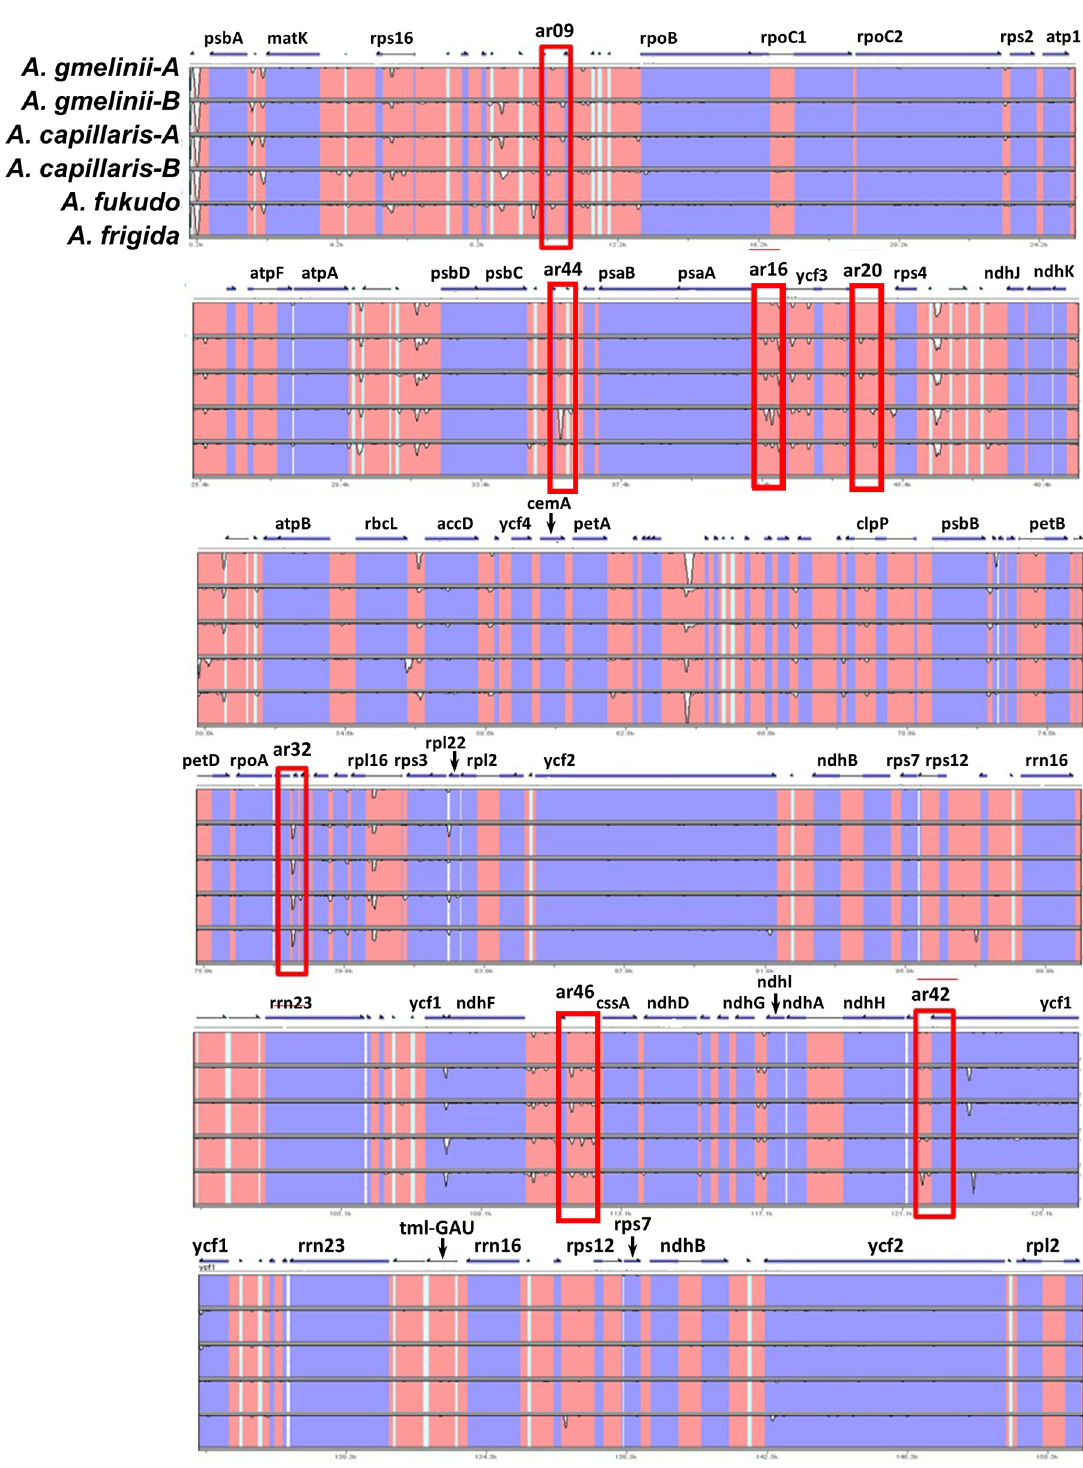
Fig 3. Chloroplast sequence variation between A . gmelinii , A . capillaris , A . fukudo , and A . frigida . The molecular markers were developed from the highly variable regions indicated by a red rectangle. The names of markers are shown above the red boxes.